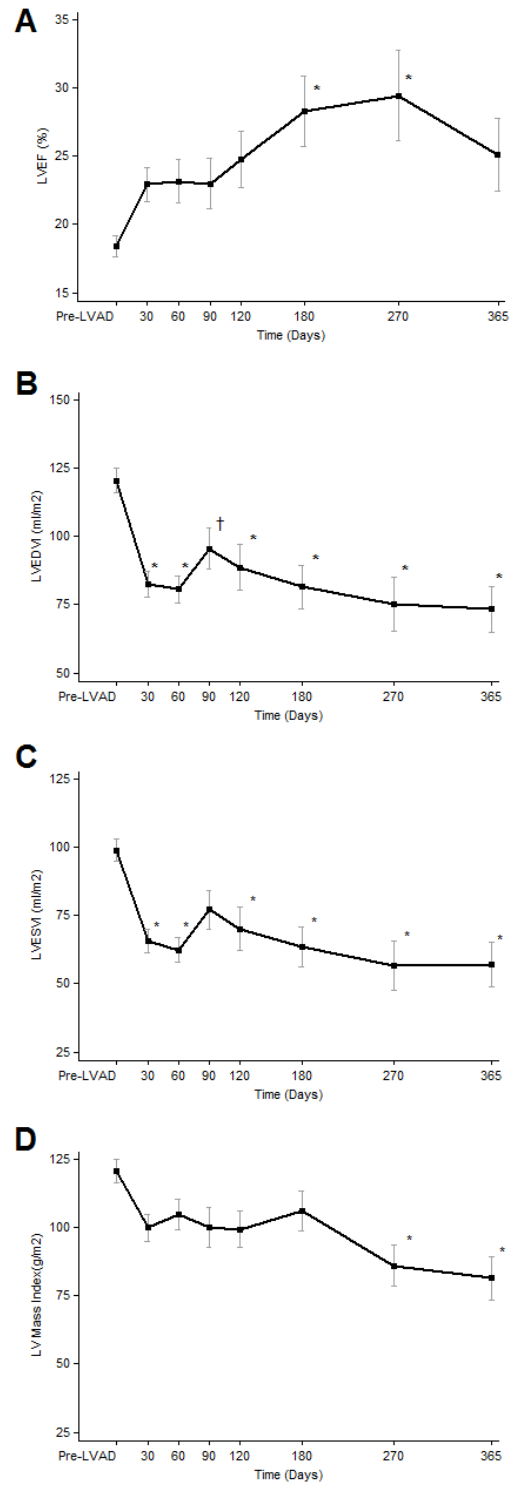
Figure 1. Serial echocardiographic changes in LVAD-supported patients. ( A ). LVEF; left ventricular ejection fraction, ( B ). LVEDVI: left ventricular end diastolic volume index, ( C ). LVESVI; left ventricular end systolic volume index, ( D ). LV (left ventricular) Mass index. Data are presented as means and confidence intervals, * p < 0.01 vs. Pre LVAD; † p < 0.05 vs. Pre LVAD. (Figure reproduced from Drakos SG et al. Magnitude and time course of changes induced by continuous-flow left ventricular assist device unloading in chronic heart failure: insights into cardiac recovery. J Am Coll Cardiol. 2013;61(19):1985–1994) [8]